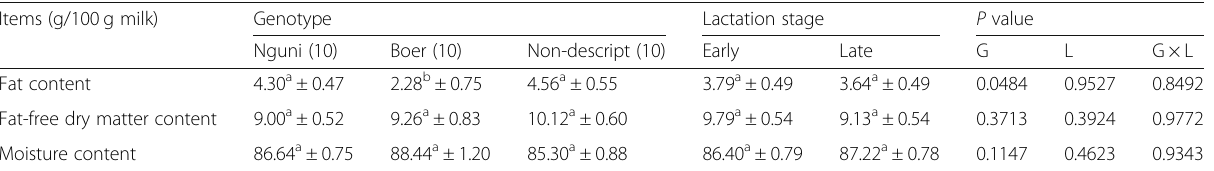
Table 1 Effect of genotype, lactation stage and interaction between genotype and lactation stage on milk composition of free- ranging indigenous goats